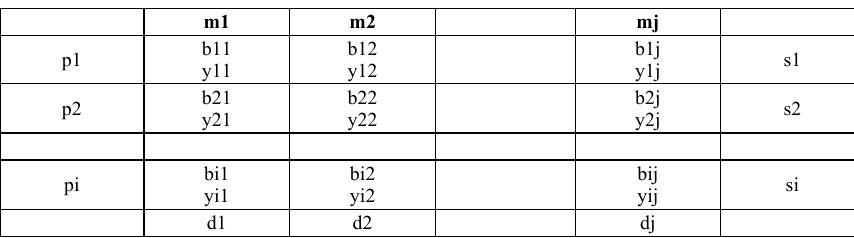
Table 3. Representation of Transportation